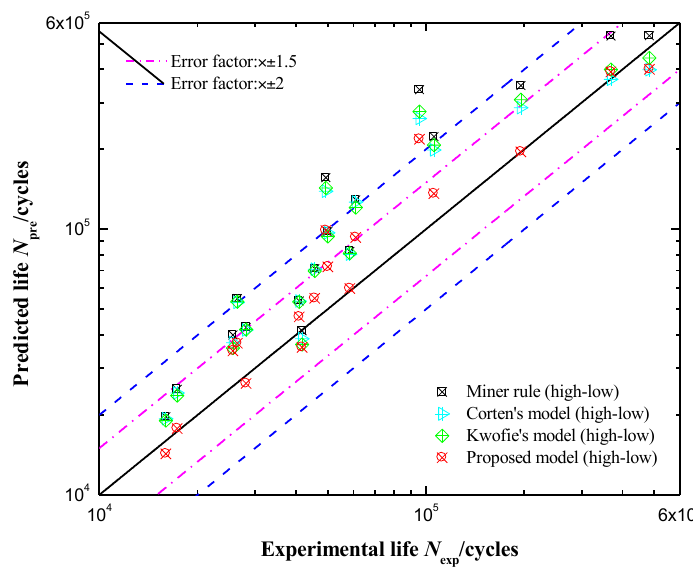
Figure 3. Comparison between the experimental lives and the predicted lives by Miner rule, Corten’s model, Kwofie’s model, and the proposed model for maraging 300 CVM steel.